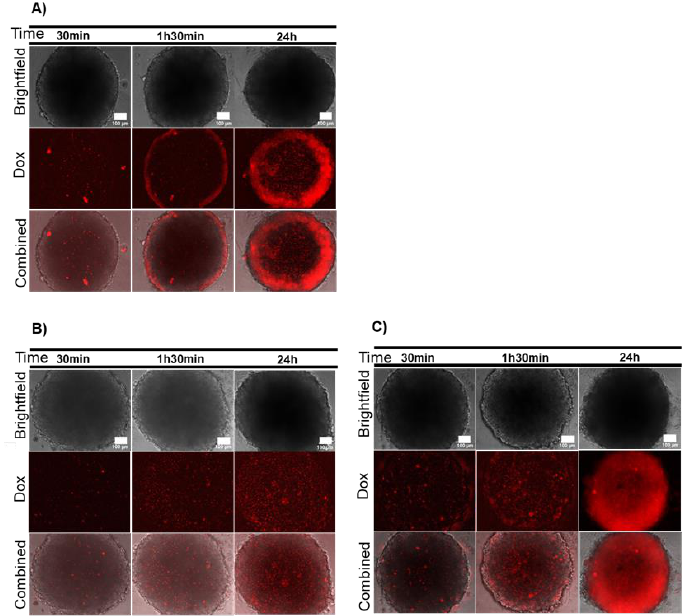
Figure 3. Dox diffusion in sensitive and resistant spheroids. ( A ) HCT116 spheroids incubated with 8 µ M of Dox; ( B ) Dox-resistant HCT116 (HCT116-DoxR) spheroids incubated with 8 µ M of Dox; ( C ) HCT116-DoxR spheroids incubated with 120 µ M of Dox. Microscopy images were acquired in Brightfield or with a red fluorescence filter after 30 min, 1 h 30 min or 24 h incubation. The combined images result from the overlap between Brightfield and red filter images. Scale bar corresponds to 100 µ m.